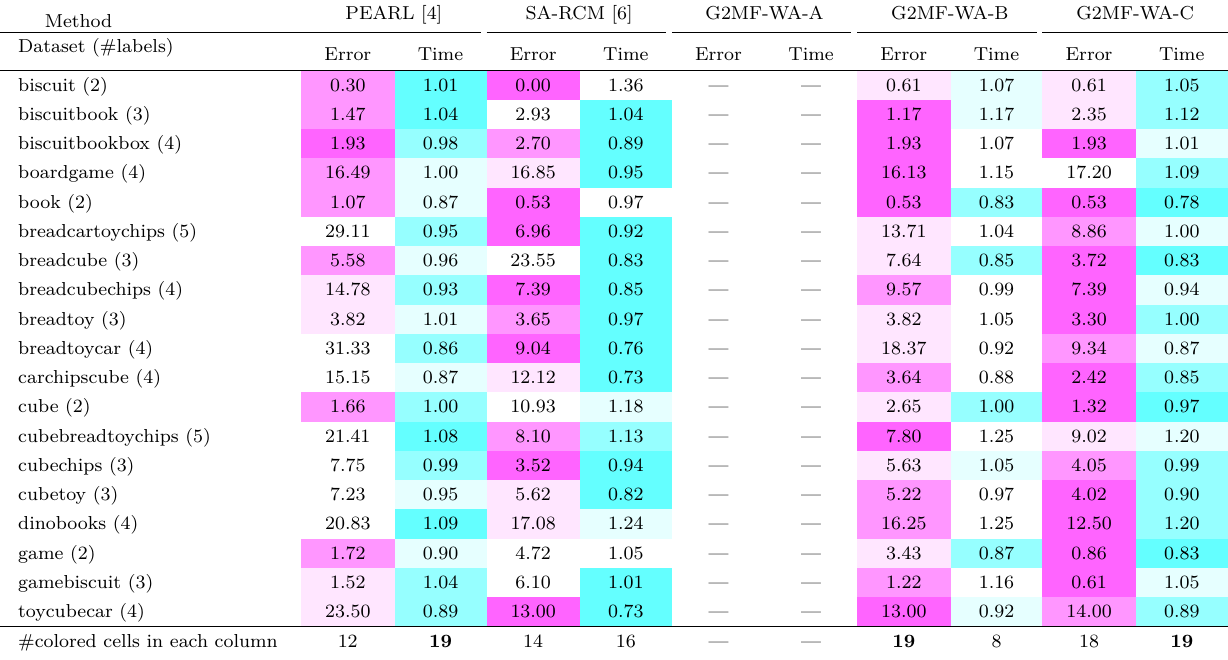
Fig. 6 Examples of two-view motion segmentation. Above: cubetoy shows the situation when the number of weak labels in (d) equals the number of ground-truth labels in (a) without considering the outlier label (red circle in (a)), i.e., 2 labels in (d) and 3 labels in (a) including the outlier. Below: game shows the situation when only one label exists. In (d) and (i), WA data points are shown. Table 2 Median results over 100 trials on the two-view motion segmentation task with full AdelaideRMF dataset (F part). Darker colors represent lower errors (%) and runtime (in seconds), denoted by fuchsia and cyan, respectively. Top-3 cells in each row are